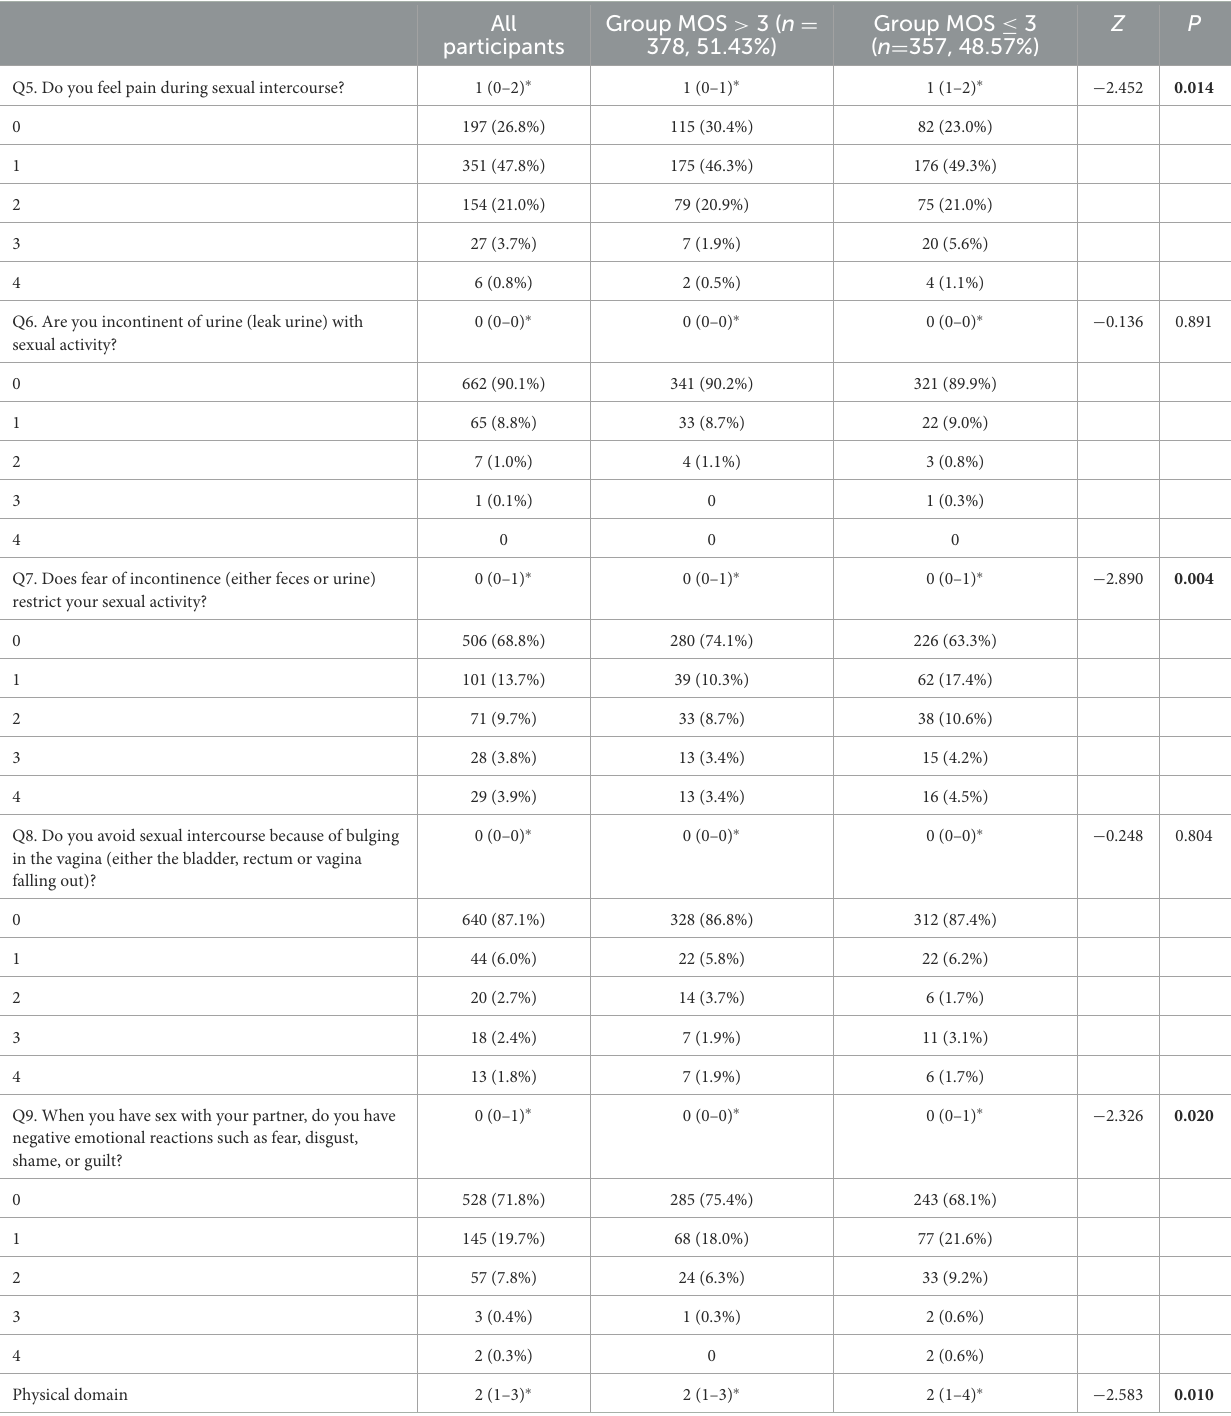
TABLE 5 The correlation between PFMS and the physical domain of PISQ-12 for all participants and the results from univariate analysis of the two groups.